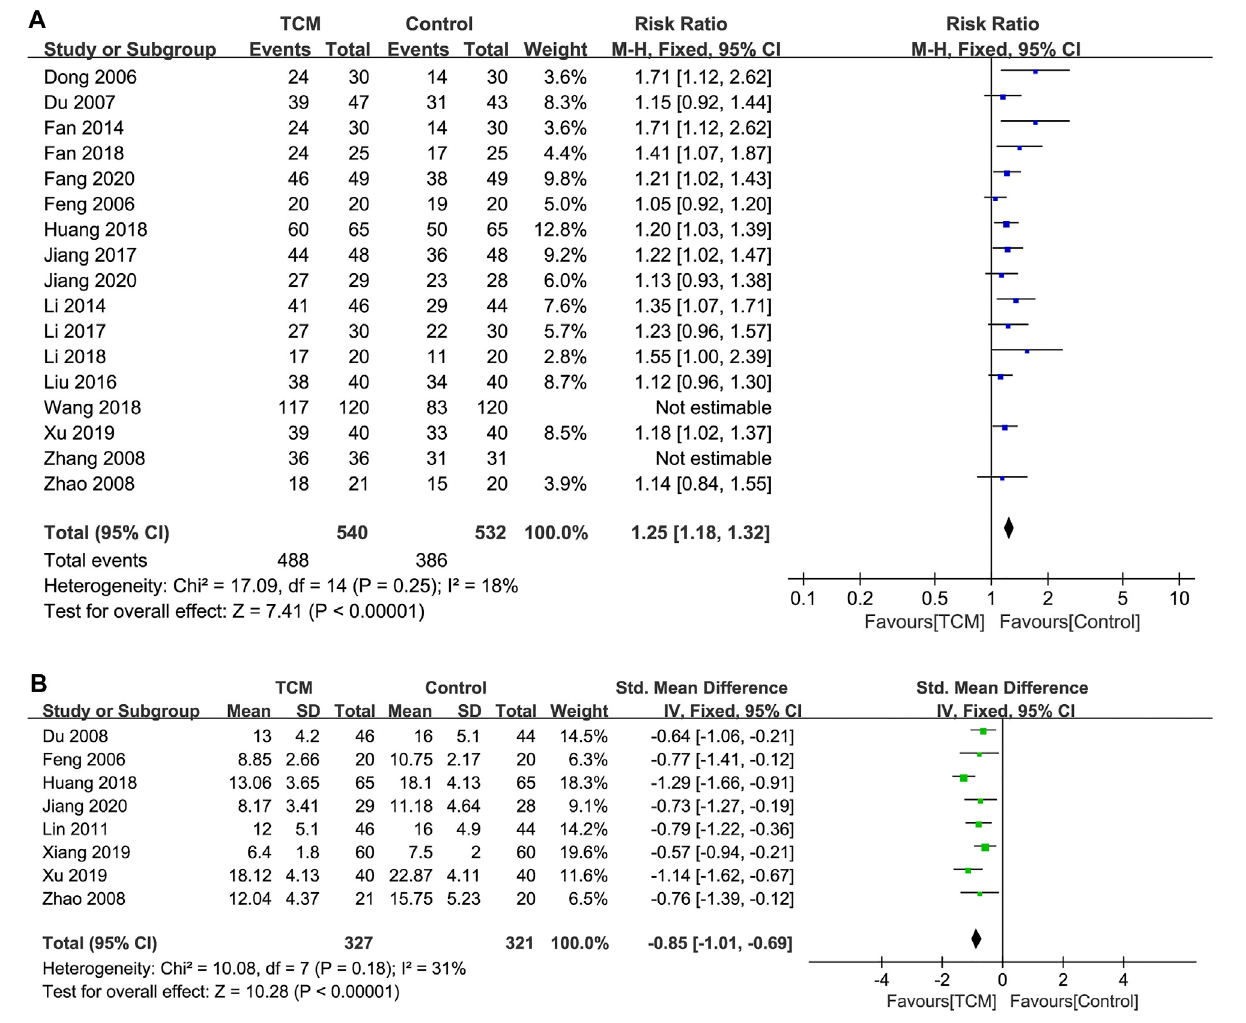
FIGURE 2 | Primary outcomes. (A) . Effectiveness. (B) .